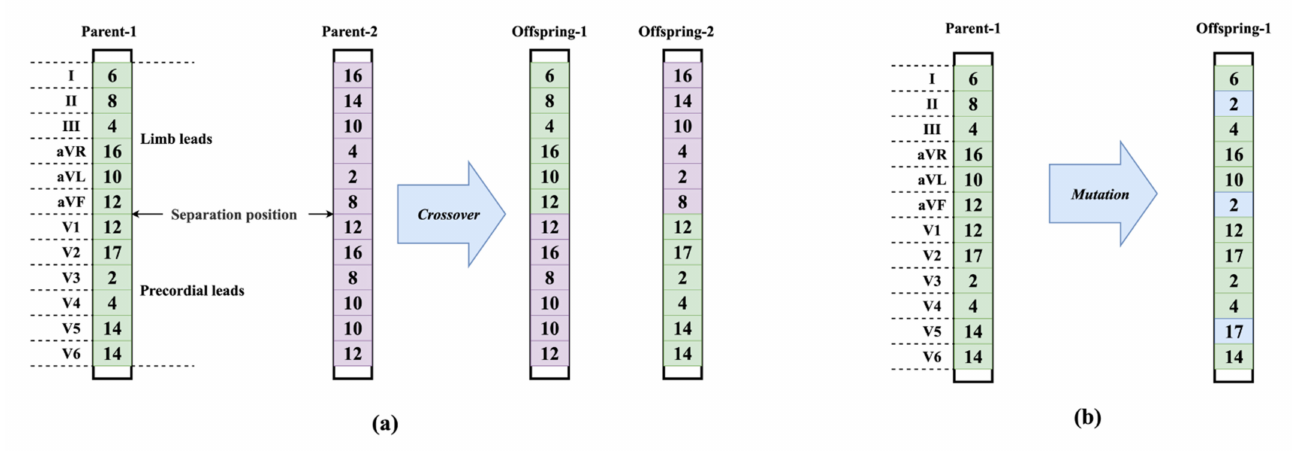
Figure 9. ( a ) An example of crossover. ( b ) An example of